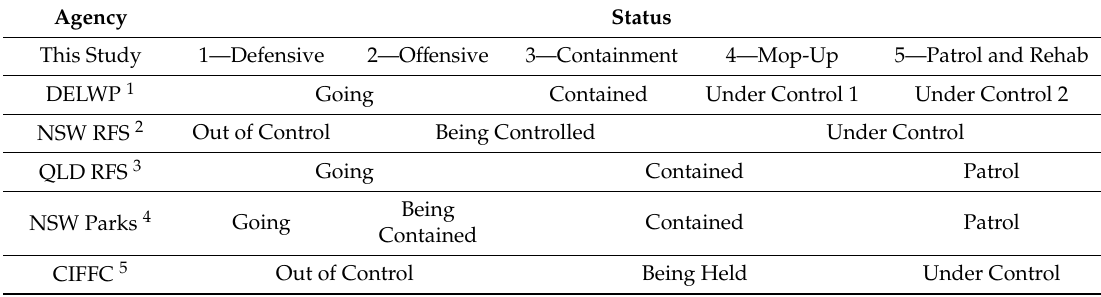
Table 1. Fire suppression stages vs. existing agency status definitions. A representation of how the proposed fire suppression stages map to existing agency definitions of fire status across jurisdictions. Agency